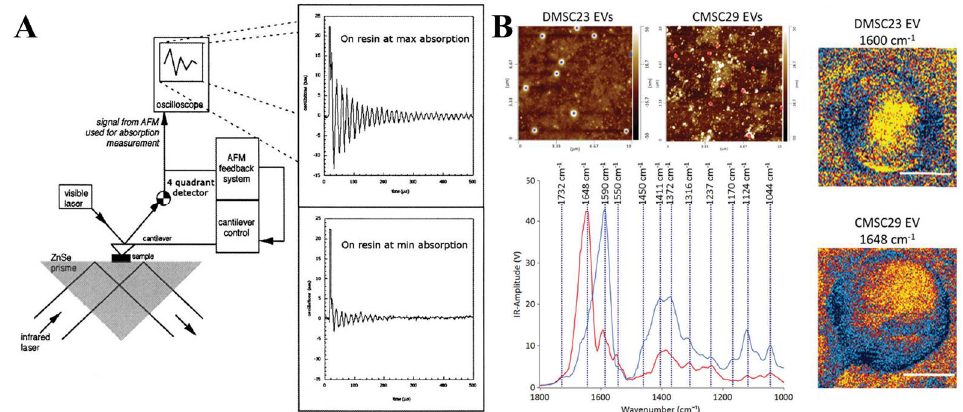
Figure 8. ( A ) Experimental setup of the first AFM−IR spectroscopy. Reprinted with permission from [82]. Copyright 2005, Optical Society of America. ( B ) The height images and averaged spectra generated from AFM-IR for two different EV populations. Averaged AFM−IR spectra of DMSC23 EVs (blue) and CMSC29 EVs (red). Reprinted with permission from [89]. Copyright 2018, Royal Society of Chemistry.